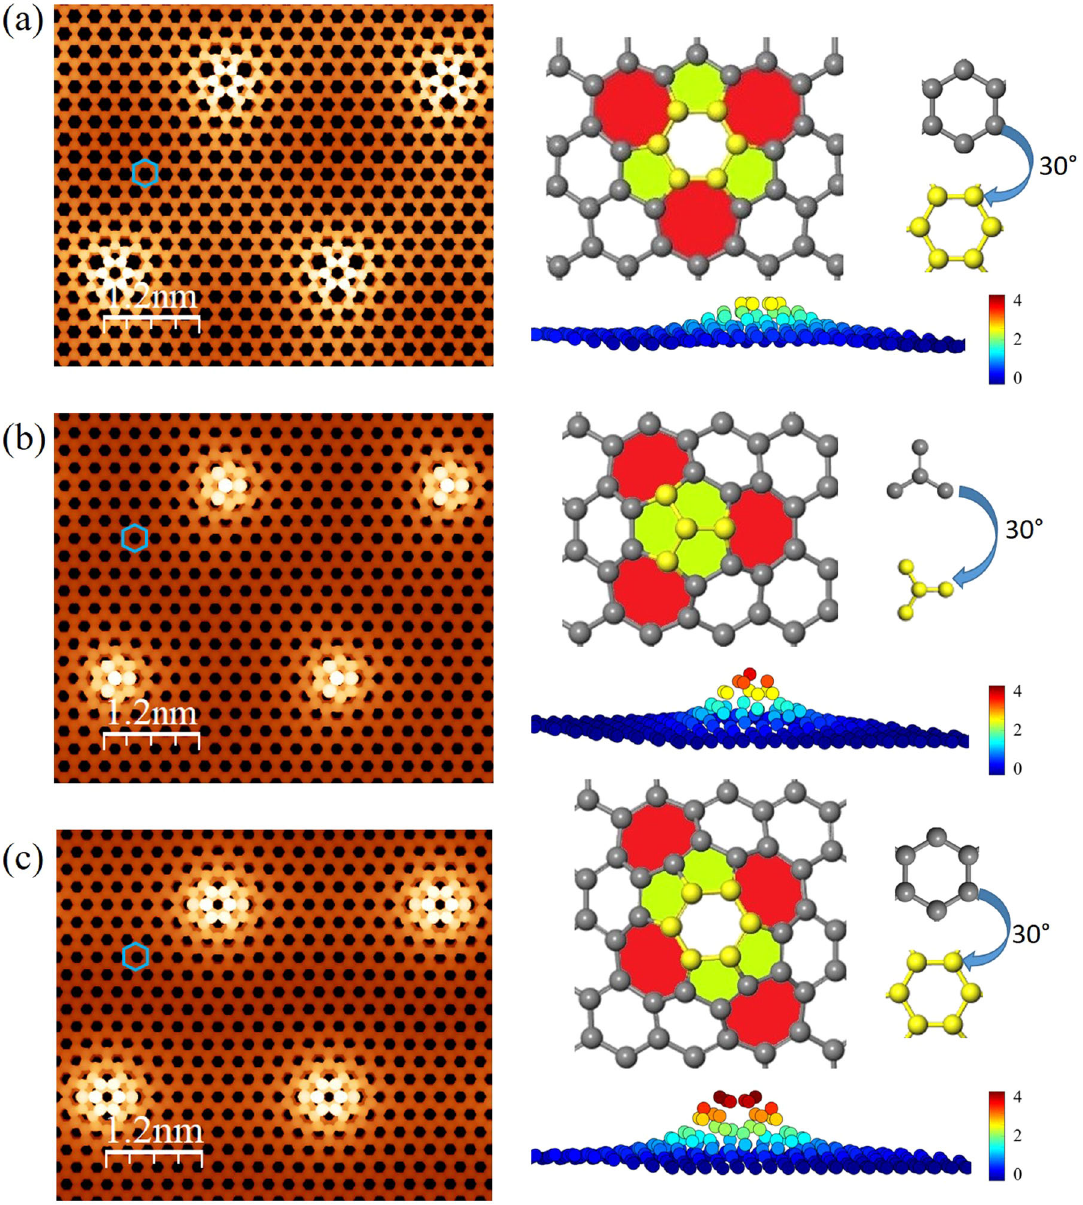
Fig. 1 The detailed structure of atomic-scale graphene blisters after structure relaxation. The simulated STM images are on the left panel, the top and side view on the right panel a C 2 , b C 4 , and c C 6 , the red and green areas represent heptagonal and pentagonal rings, the color bars with the side view are represent out of plan distortions in